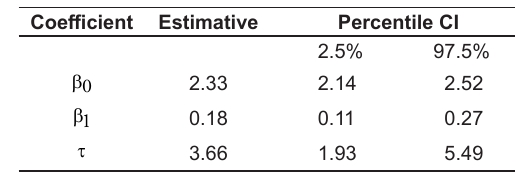
Table 2. Estimates and percentile confidence intervals for the parameters of the fitted piecewise linear model with hyperbolic smooth